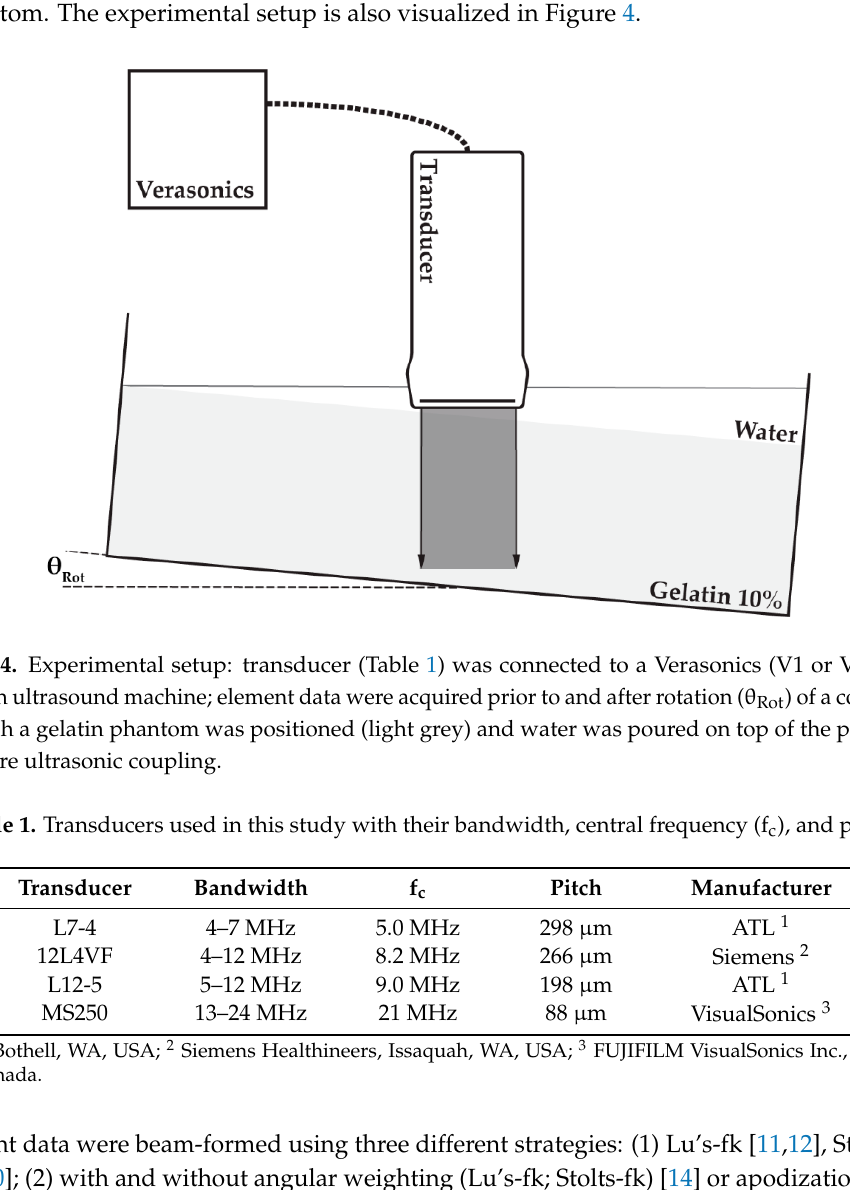
Table 2. Settings of the displacement estimation algorithm and displacement grid (DispGrid).